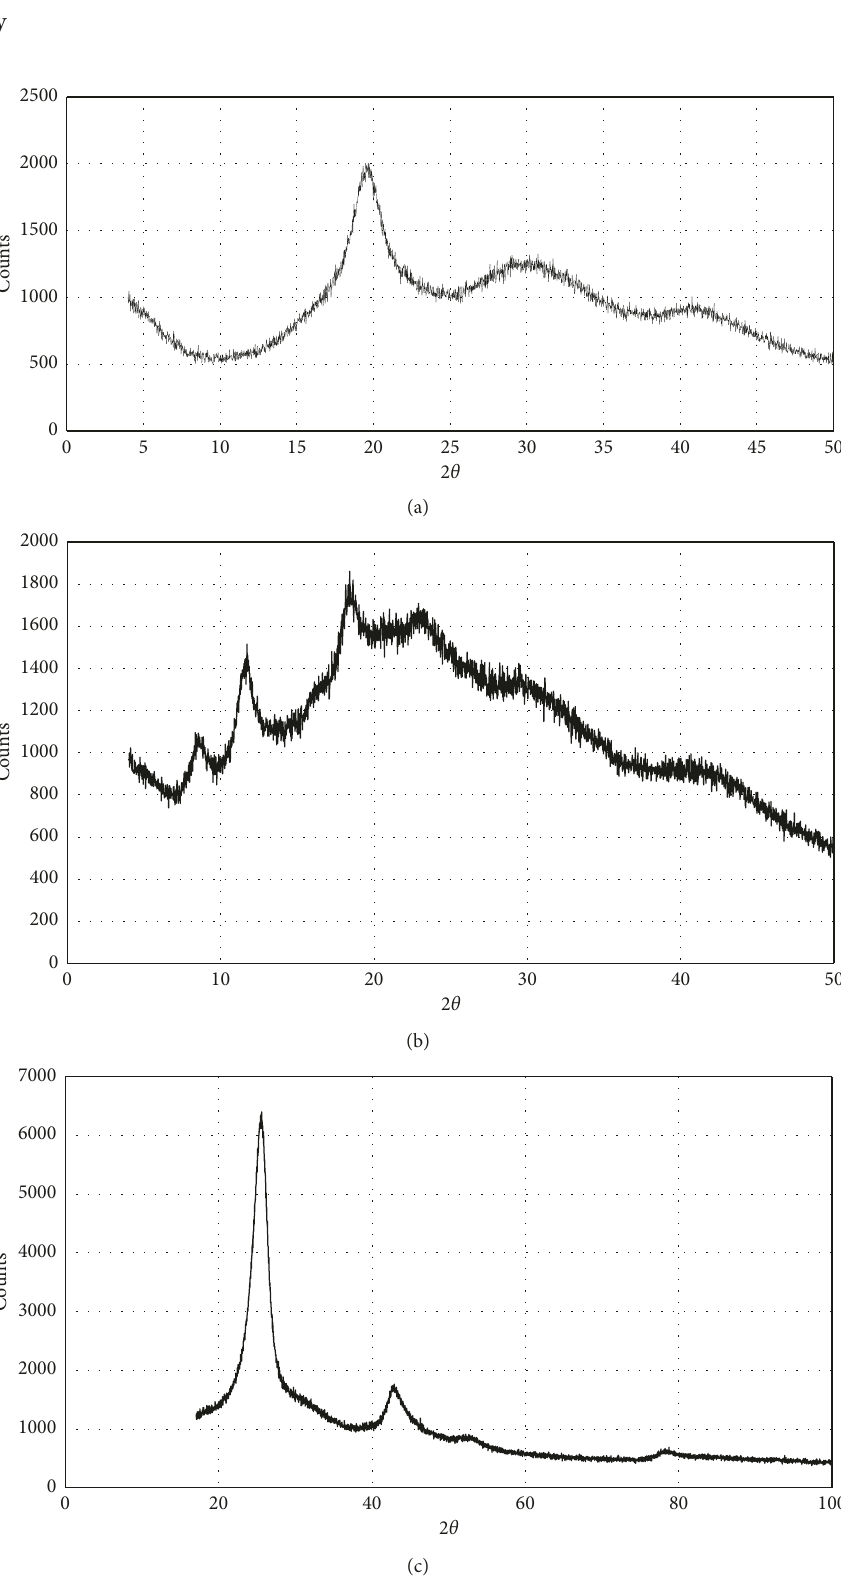
Figure 4: XRD patterns of carbon black and the prepared films. (a) PVA/C, (b) Chit/C, and (c) carbon